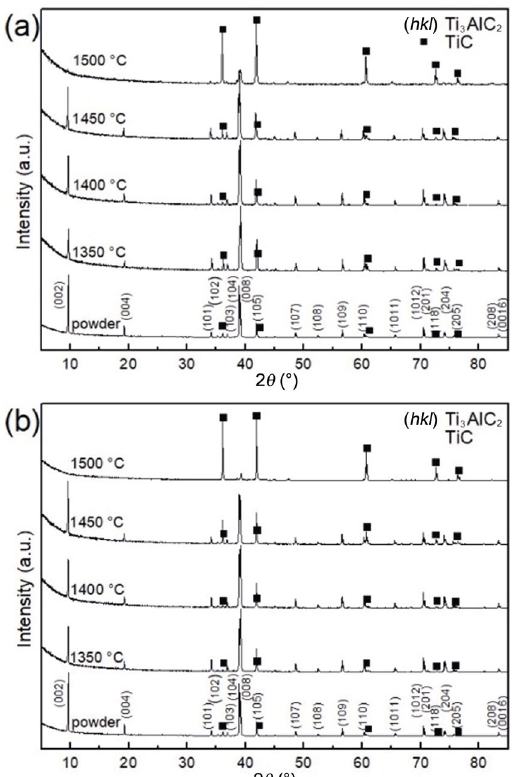
Fig. 8 XRD patterns of the samples 1A10 sintered at 1350–1500 ℃ for 1.5 h (a) with Al 4 C 3 embedding powders and (b) without Al 4 C 3 embedding powders.